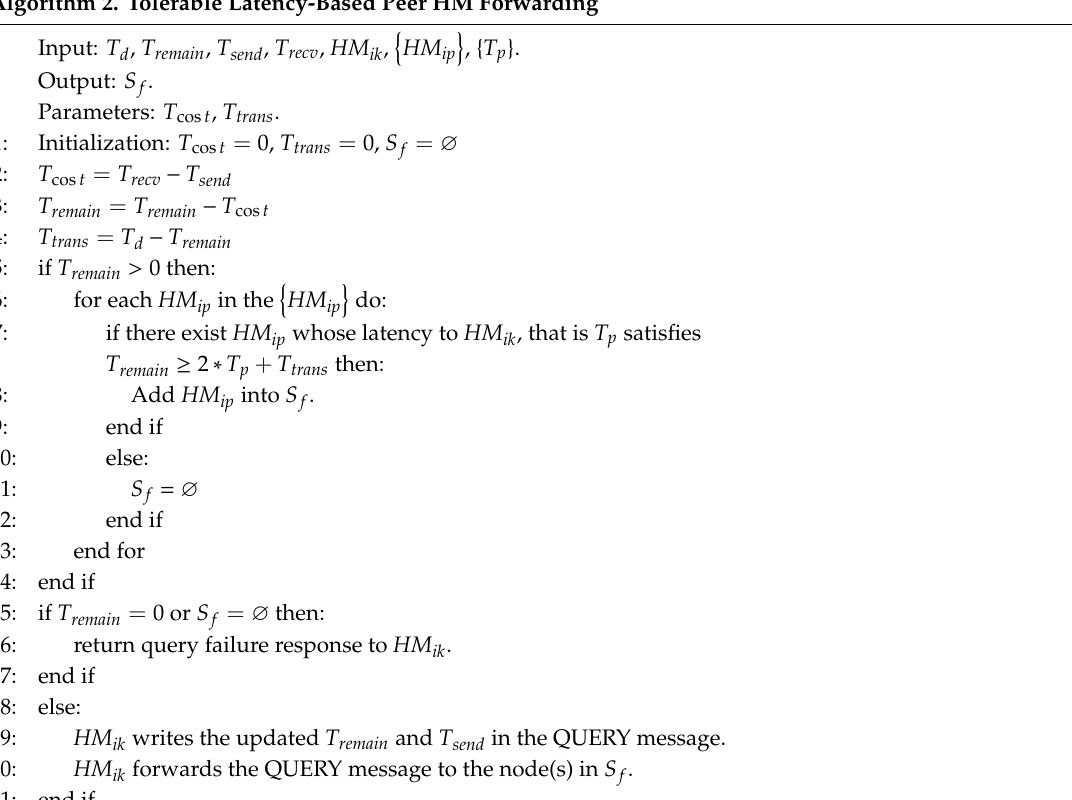
Algorithm 2. Tolerable Latency-Based Peer HM